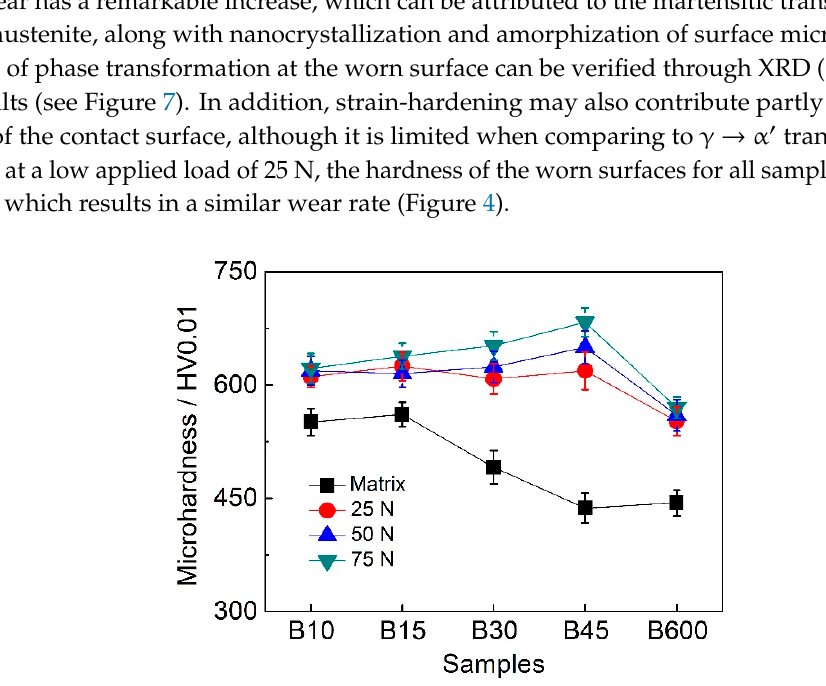
Figure 8. Microhardness of the matrix and worn surfaces of all samples after wear testing under 25 N, 50 N, and 75 N, respectively.